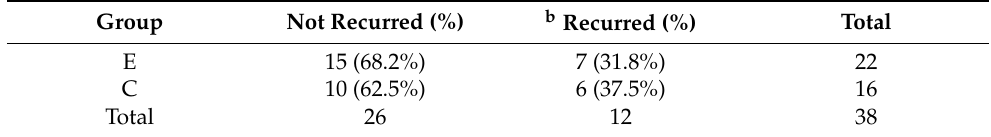
Table 4. The recurrence rate of two groups (at 3-month visit) a . Group Not Recurred (%) b Recurred (%) E